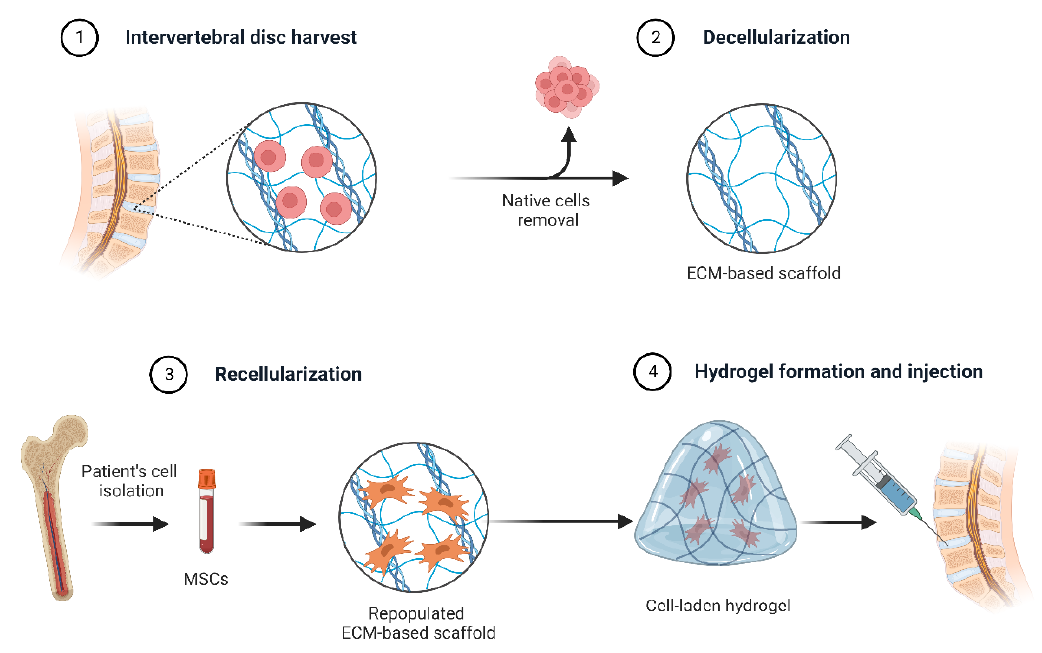
Figure 4. Strategies for regenerating the intervertebral disc using extracellular matrix. Decellularized tissue-based extracellular matrix (ECM) scaffolds have been studied widely in regenerative medicine for use in tissue